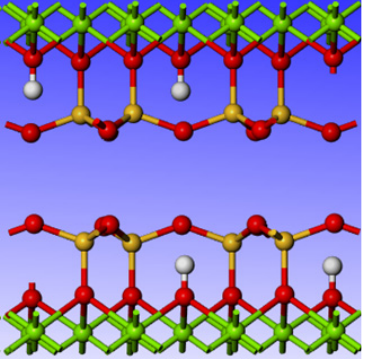
Figure 1. Primitive cell structure of talc.